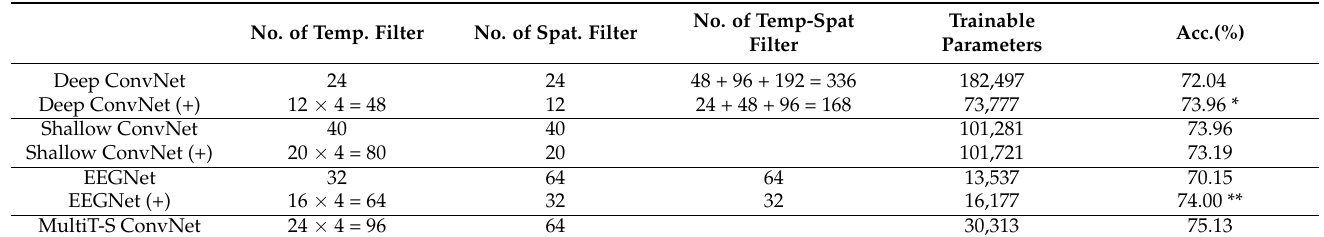
Table 2. The number of filters, trainable parameters, and accuracies before and after applying multi-kernel convolution on the SEED